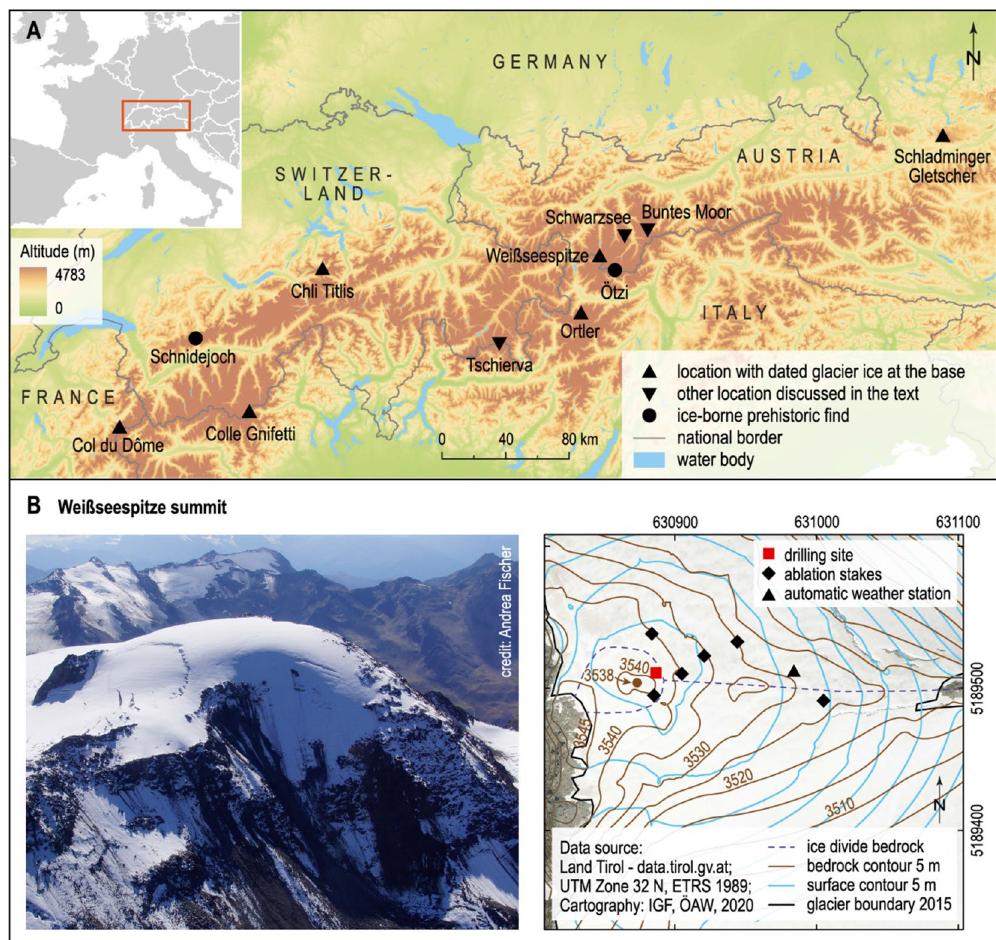
Figure 1. The location of the Weißseespitze summit glacier, the discovery site of the Tyrolean Iceman (“Ötzi”) and other sites discussed in the text ( A ). Shown in the bottom row is a close up of the glacier topography at Weißseespitze summit and the precise drilling location ( B ). Note the unique dome shape of the summit glacier. Data sources part A: EuroBoundaryMap, copyright EuroGeographics; CCM River and Catchment Database copyright European Commission—JRC, 2007; CIAT-CSI SRTM (http://srtm.csi.cgiar .org); Cartography: IGF, ÖAW, 2020; under a CC-BY-NC-SA 4.0 International License (https ://creat iveco mmons .org/licen ses/ by-nc-sa/4.0/). Maps made with licensed software Arc Map 10.6.1 (https ://deskt op.arcgi s.com/en/arcma p/), figure made with licensed software Adobe Illustrator CS6 (https ://www.adobe .com).